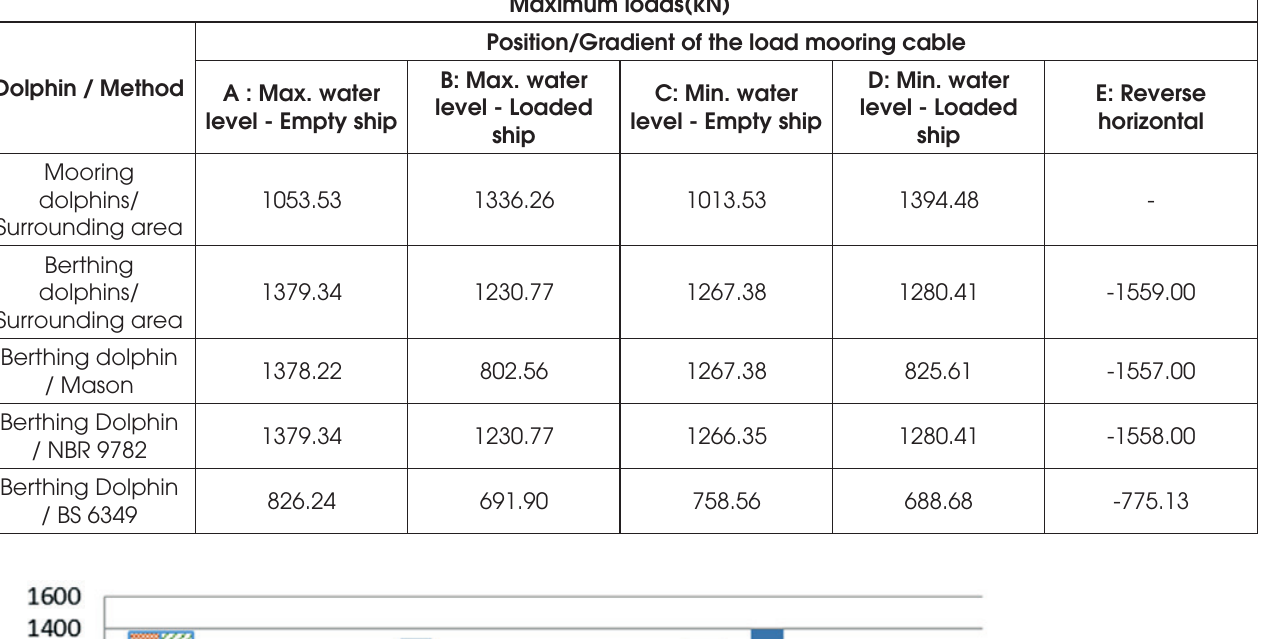
Maximum loads on dolphins due to mooring for each cable gradient or position, by method